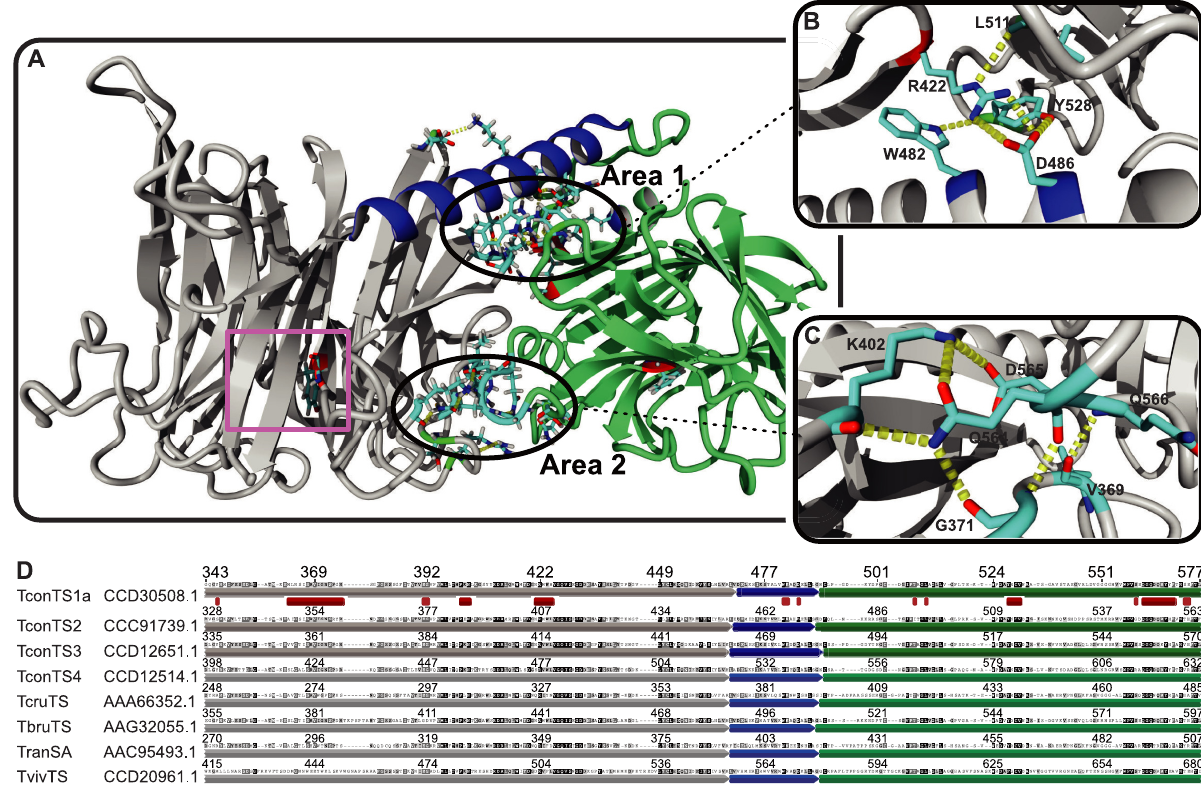
Fig 1. Hydrogen bond network at the interface between CD and LD of TconTS. A: homology model of TconTS1a using the crystal structure of TcruTS (PDB code: 3B69) as template structure as described under Methods. Area 1 and 2, comprising a network of hydrogen bonds formed by amino acid residues at the interface between catalytic domain (CD in grey), interdomain α -helix (blue) and lectin domain (LD in green) are marked. The active centre containing the catalytic tyrosine residue Tyr438 at the CD is labelled with a purple square B-C: Zoom of Area 1 and Area 2 showing the conserved hydrogen bond network (yellow dotted lines), respectively. D: Amino acid sequence alignment (see Methods for details) of TconTS1a through TconTS4, T . cruzi TS (TcruTS EMBL: AAA66352.1), T . brucei TS (TbruTS EMBL: AAG32055.1), T . rangeli sialidase (TranSA EMBL: AAC95493.1) and T . vivax TS (TvivTS EMBL: CCD20961.1). Only a section of the complete alignment is shown including contact sites between CD and LD. CD is labelled in grey, α - helix in blue and LD in green respectively. Sequence segments being part of the interface between CD, α -helix and LD are marked with red squares. Increasing background darkness for each residue of the sequence indicates increasing number of identical amino acid residues at the corresponding position over the alignment (see Methods for